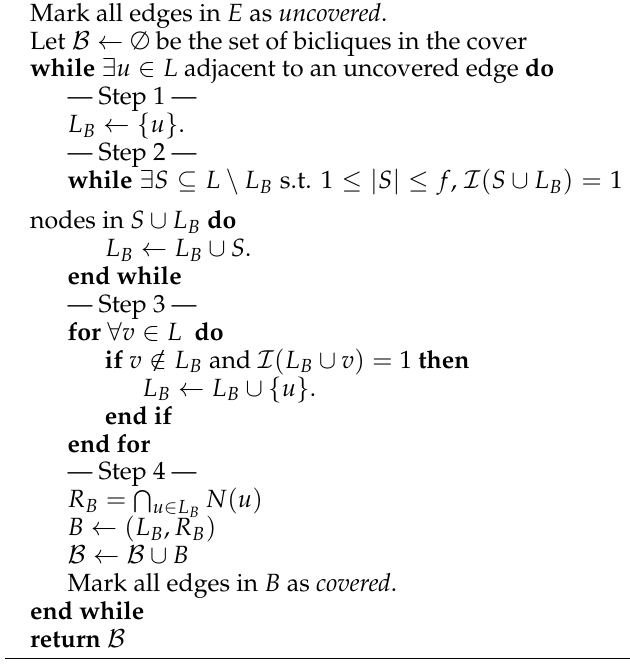
Algorithm 2 OptCoverOneSideRandom( G = ( L , R , E ) , f , p m , k ) Mark all edges in E as uncovered